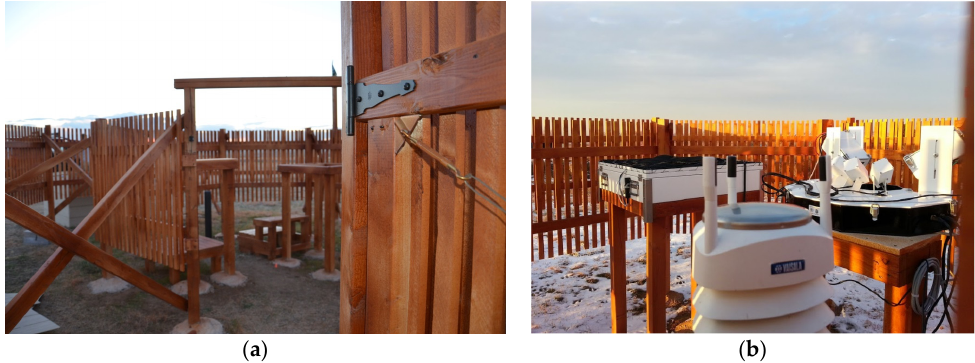
Figure 16. MASCRAD Snow Field Site at Easton Valley View Airport, Colorado: ( a ) 2/3-scaled DFIR double wind fence right after construction in October 2014 and ( b ) 2DVD, VAISALA, and MASC instruments operating within the DFIR fence.